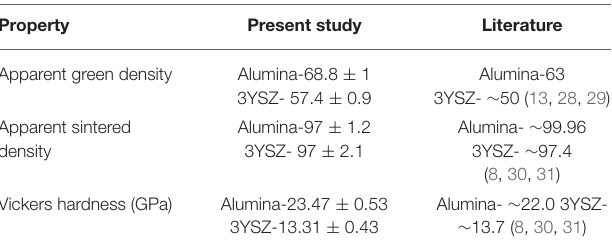
TABLE 2 | Representation of measured values of density and hardness in this study compared with those in the literature.